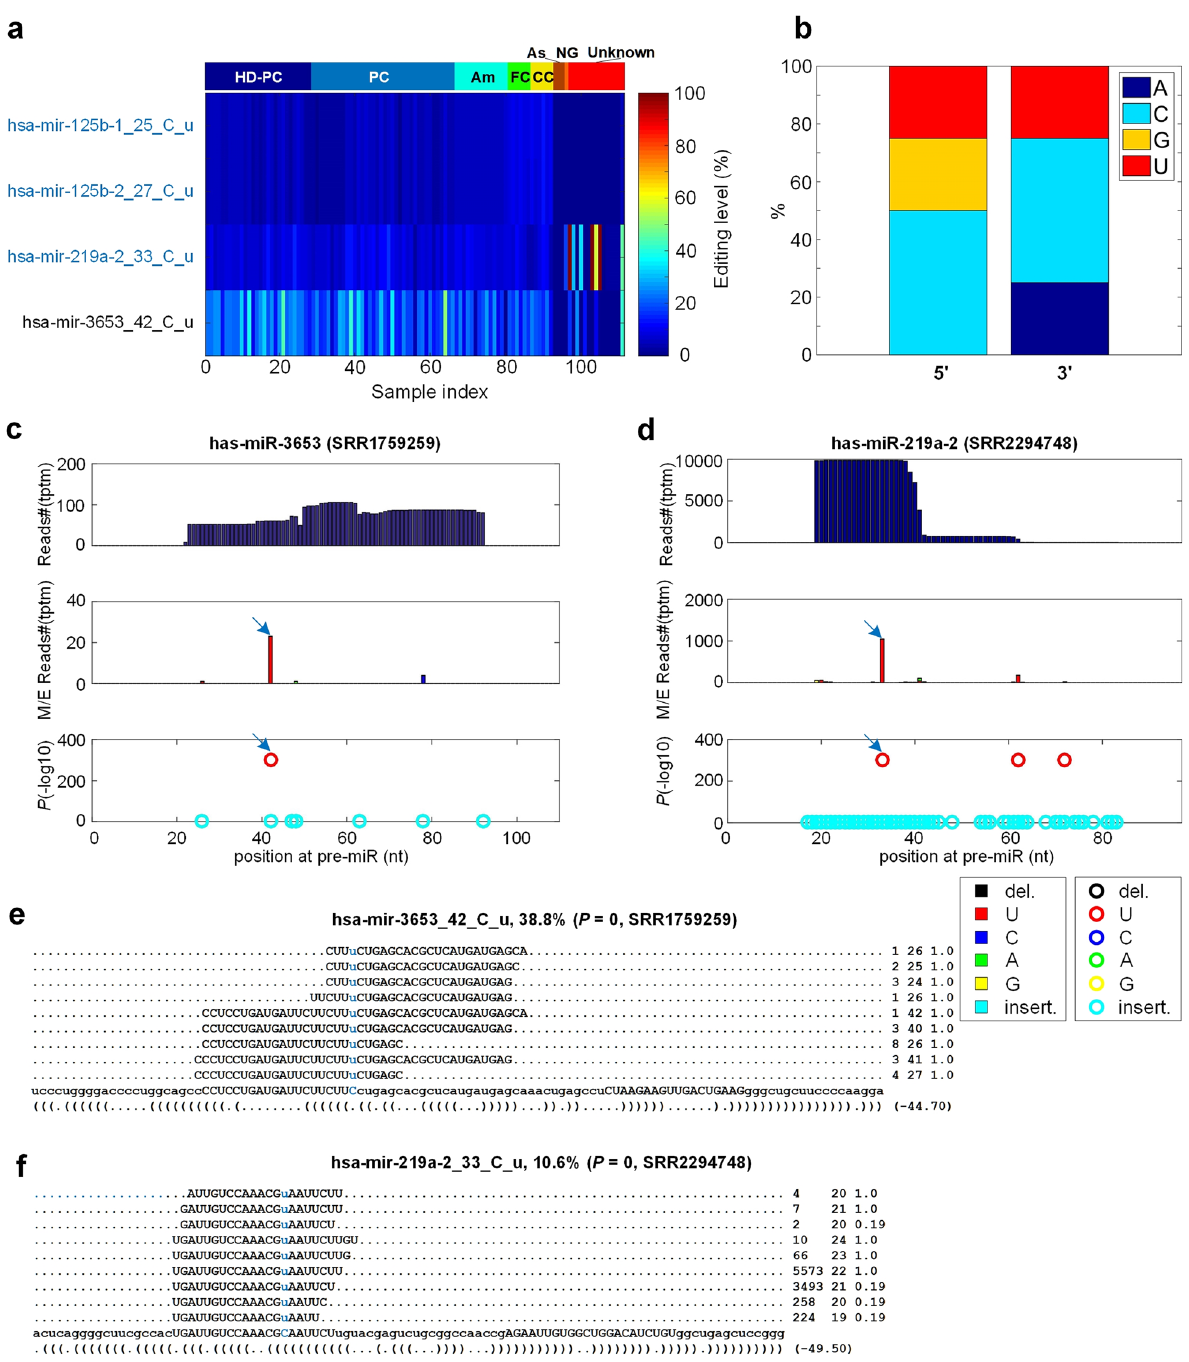
Figure 3. The detailed information of C-to-U editing sites in miRNA of HD samples. Legends are the same as those in Fig. 2. ( a ) The editing levels of 4 C-to-U sites in the 111 selected sRNA-seq profiles. ( b ) The base distribution of C-to-U sites at 5’ and 3’ end of mature miRNA. ( c ) MiRME map of hsa-mir-3653 in one of the HD-PC samples selected (SSR1759259). ( d ) MiRME map of hsa-mir-219a-2 in one of the Am samples selected (SSR2294748). ( e ) The details of hsa-mir-3653_42_C_u in SRR1759259. ( f ) The details of hsa-mir-219a- 2_33_C_u in SRR2294748. In Part (e)-(f), the edited nucleotides are shown in blue. And the first number on the right indicates the number of raw sequencing reads, the second number indicates the length of the reads, and the third number indicates the weight of the reads on this locus as calculated by the cross-mapping correction algorithm 84